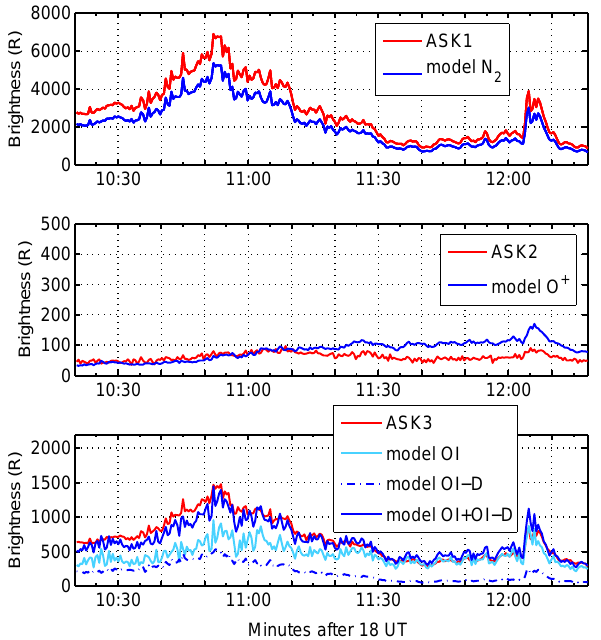
Fig. 8. Comparison of measured and modelled emission bright- nesses for the three ASK cameras.